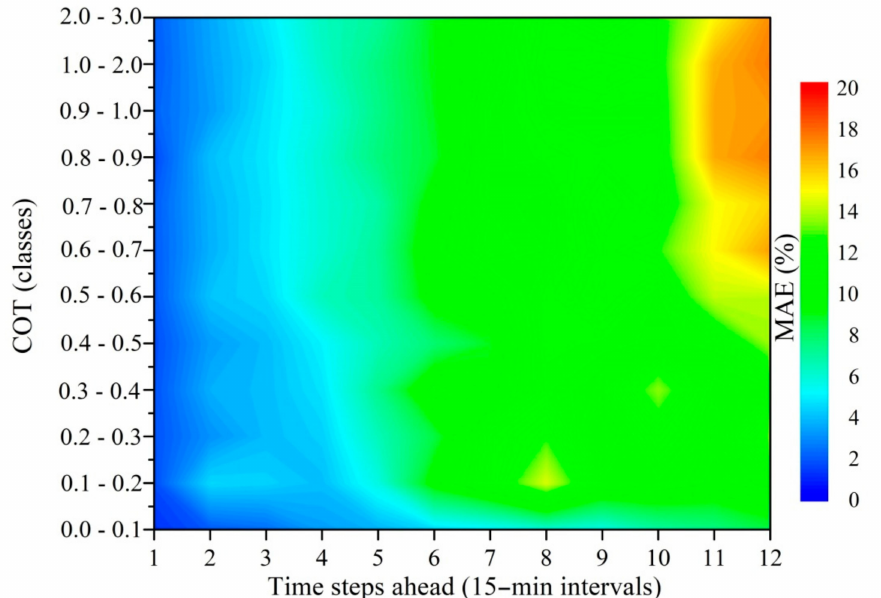
Figure 6. Contour plot of the FRB forecasted COT mean absolute error (MAE) percentage as a function of COT classes for 3 h ahead at 15 min intervals.